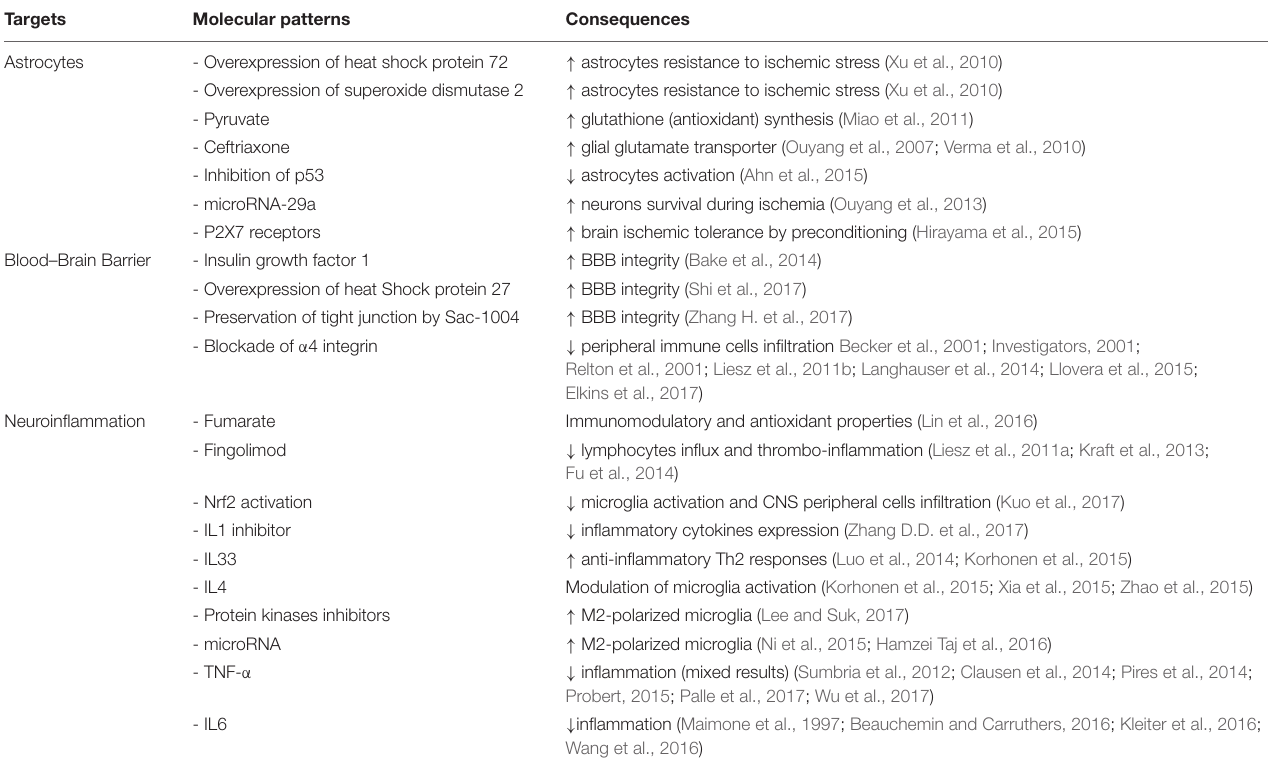
TABLE 1 | Common therapeutic targets for multiple sclerosis and ischemic stroke. Targets Molecular patterns